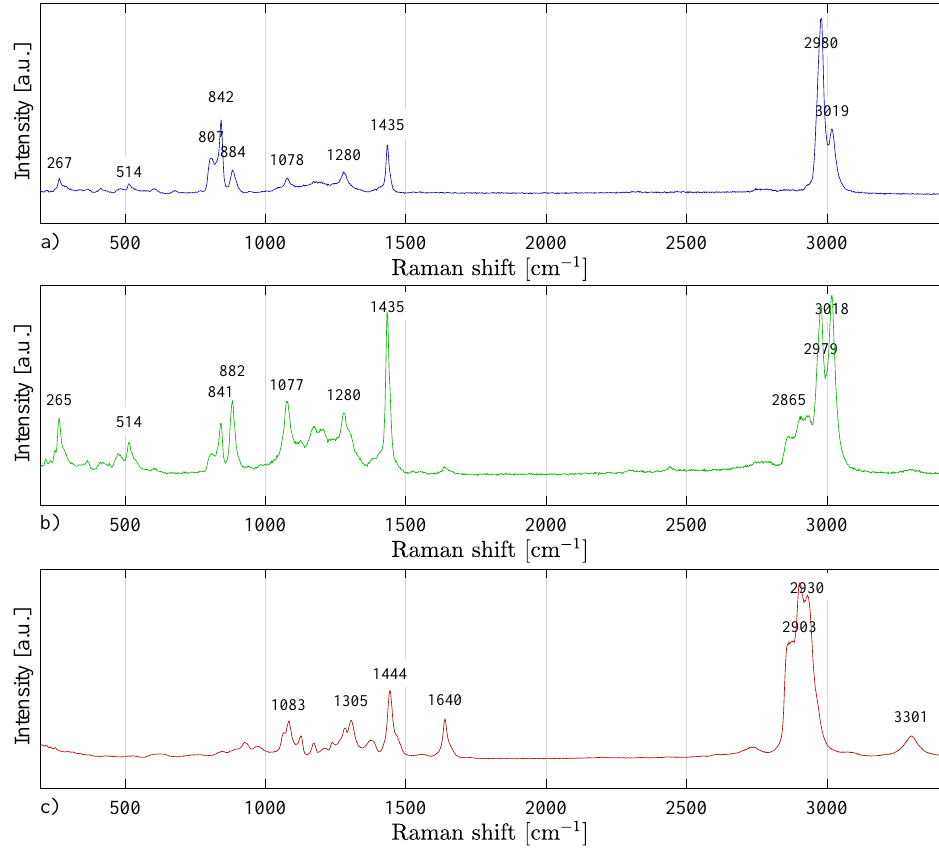
Figure 10. Raman spectra of ( a ) PVDF, ( b ) PVDF/PA6, and ( c ) PA6. In Figure ( b ) it is possible to successfully observe both PVDF and PA6 characteristic peaks.